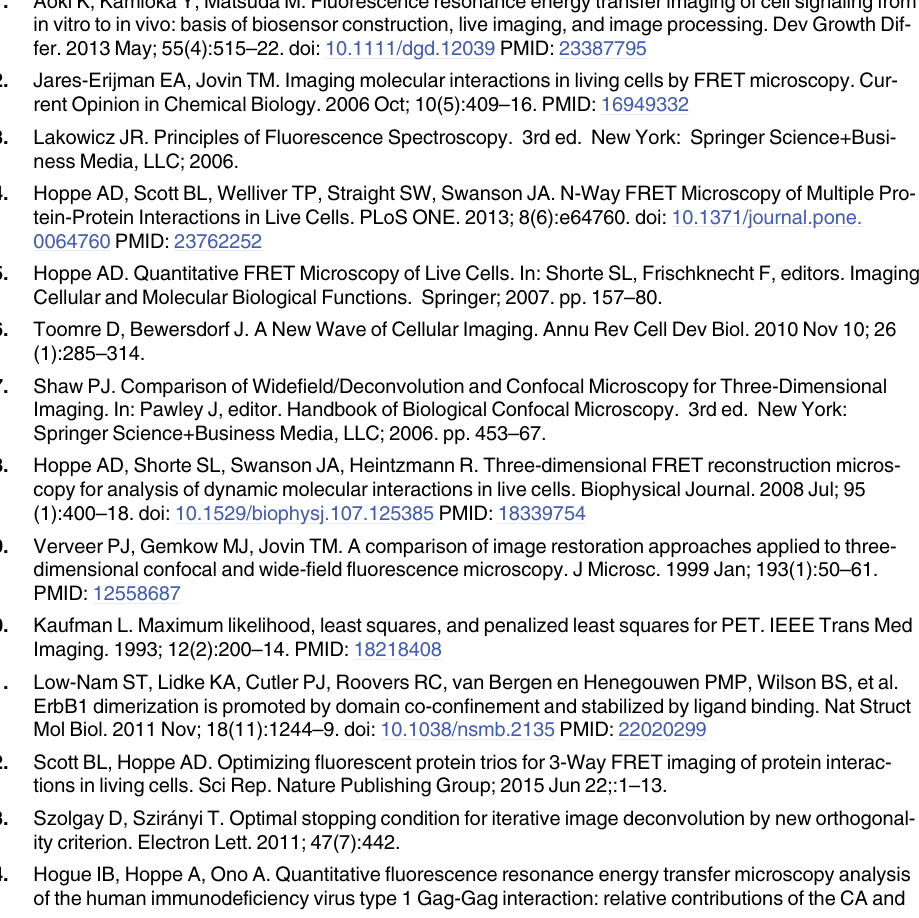
S5 Fig. DBSC and dDBSC plots associated with data in Fig 5. The potential stopping criteria were calculated for an ROI of the xy plane shown in Fig 5. (TIF) S1 Movie. 3D volume rendering of 3D-3Way FRET reconstruction. The movie shows the progression of the reconstruction of [C] (CFP-Gag) through iteration (time) for data associated with Fig 5.